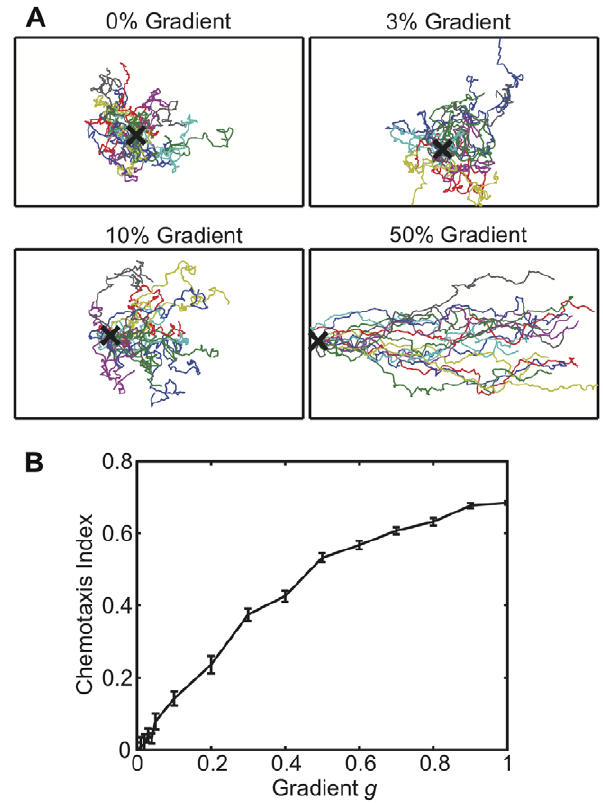
Figure 6. Chemotaxis simulations. A) 5 hour paths of model cells with the indicated gradient of k 0 . All paths are shown at the same scale, and the cells’ starting point is marked with an X. B) Chemotactic index as a function of gradient, as defined in Methods. Error bars indicate the standard error of the mean over 16 simulated cells.